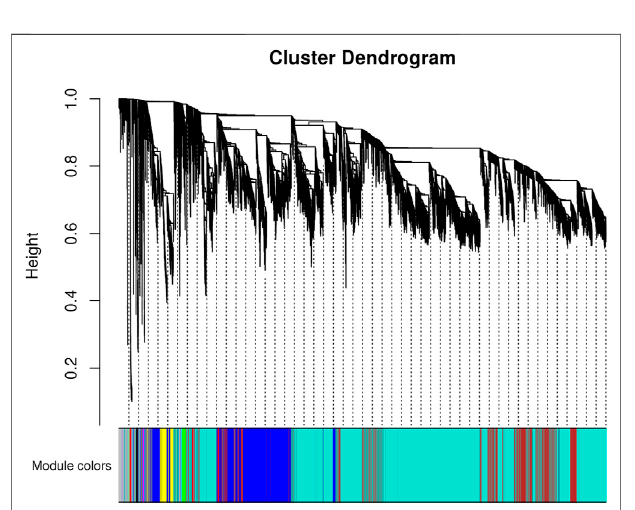
FIGURE 4 | The gene cluster dendrogram constructed by all genes ’ correlation coef fi cients. The vertical distance of the line shows the distance between different genes.